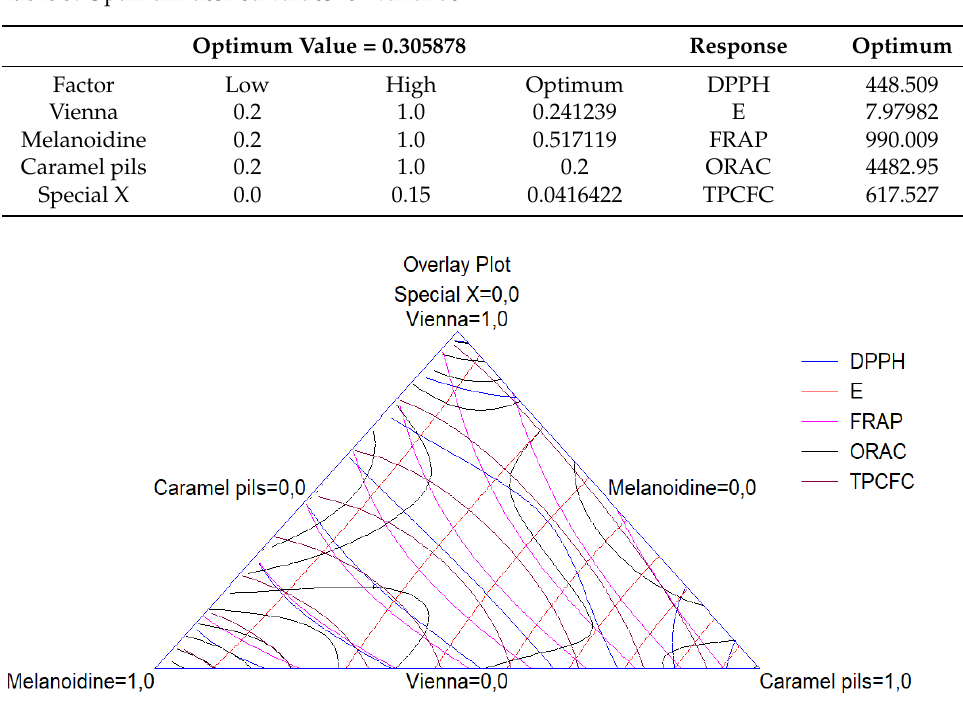
Figure 9. Graphical optimization of Variant 5 according to Table 4. (the “ , ” character represents a decimal point). Table 5. Optimum desired values for Variant